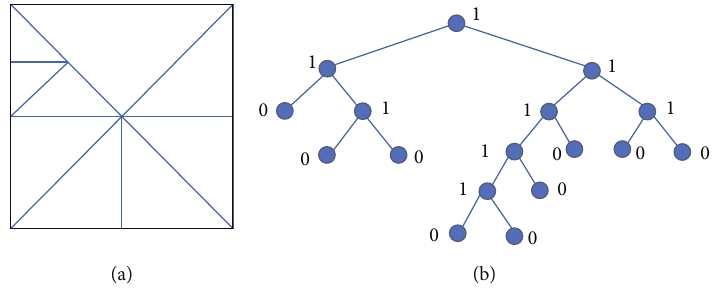
Figure 5: (a) Separation of the image into triangular areas, (b) corresponding binary